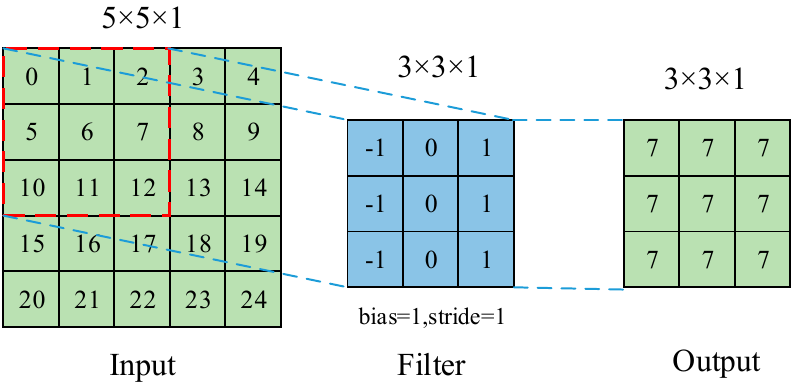
region. As for average pooling, the output is the average of each region. Convolutional and pooling layers often appear alternately in applications. Each neuron in the fully con- nected layer is connected to the upper neuron, and the multidimensional features are in- tegrated and converted into one-dimensional features in the classifier for classification or the multidimensional features are integrated and converted into one-dimensional features in detection tasks [44]. the classifier for classification or detection tasks [44].